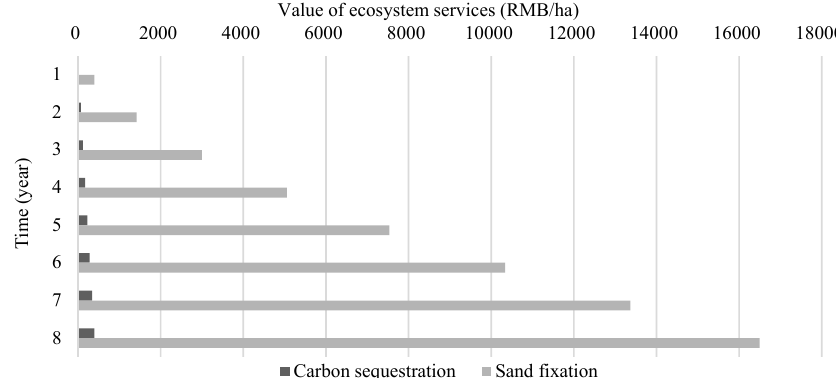
Figure 4. Values of ecosystem services provided by afforestation.